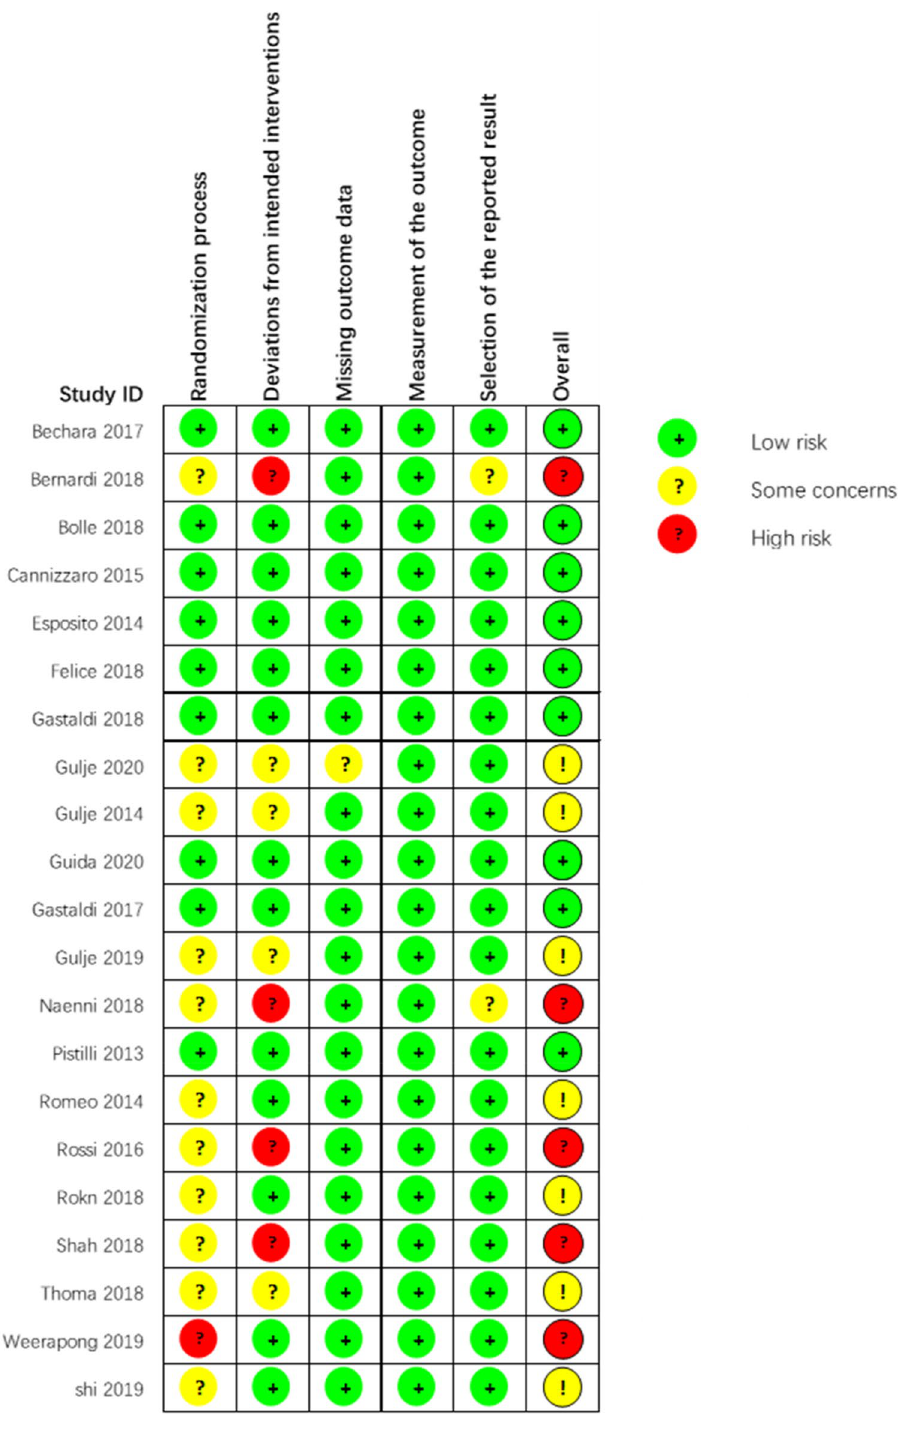
Table 2. Quality assessment of included studies by ROB 2. Generated by RevMan Web, https:// revman. cochr ane.